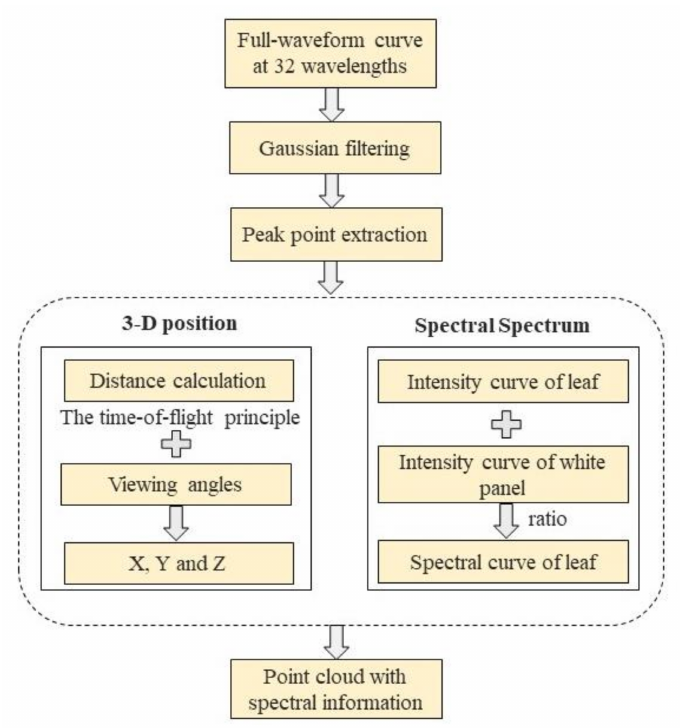
Figure 2. Flowchart of HSL data